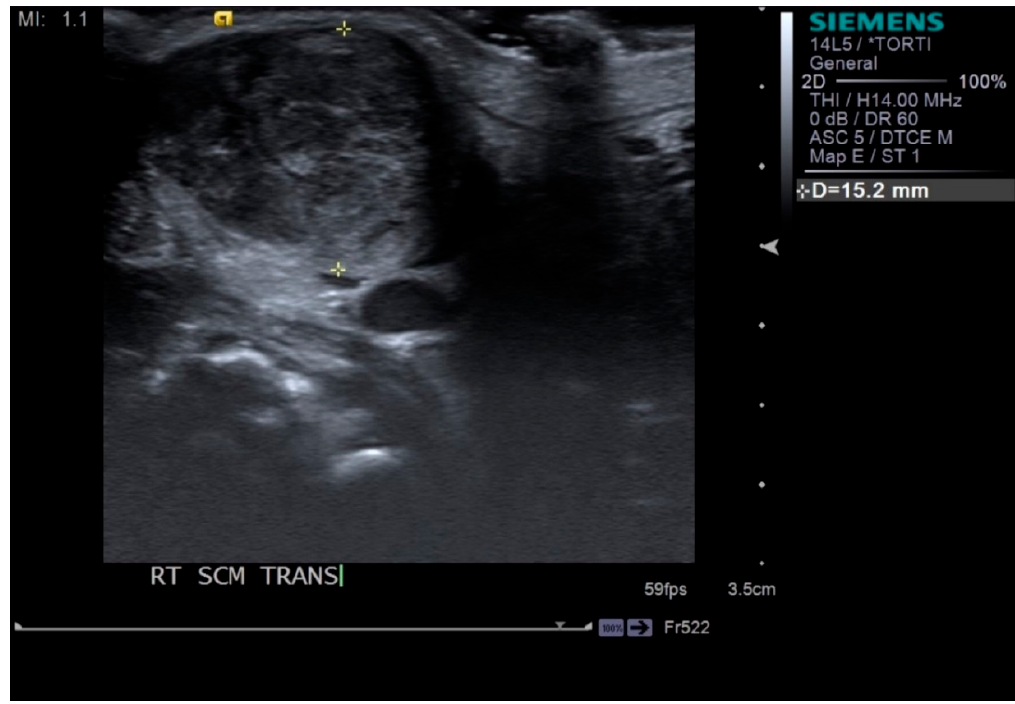
Figure 2. Thickness of sternocleidomastoid (SCM) muscle measured by electronic calipers in the transverse plane.